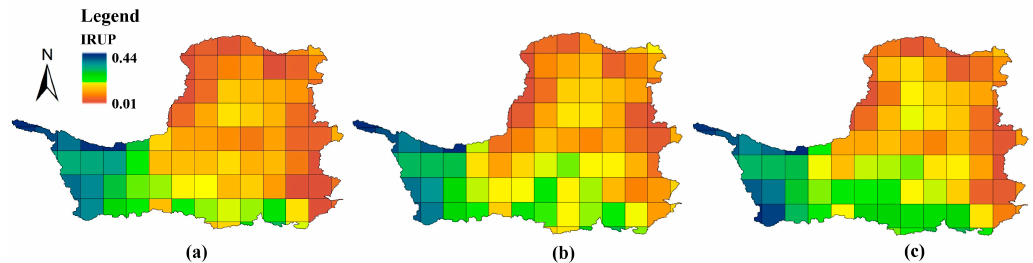
Figure 7. The spatial distribution of the IRUP in three stages: ( a ) the spatial distribution of the estimated annual IRUP in the middle stage after the Grain for Green Project launched (2003–2009) and ( b ) the spatial distribution of the estimated annual IRUP in the late stage after the Grain for Green Project launched (2010–2014).